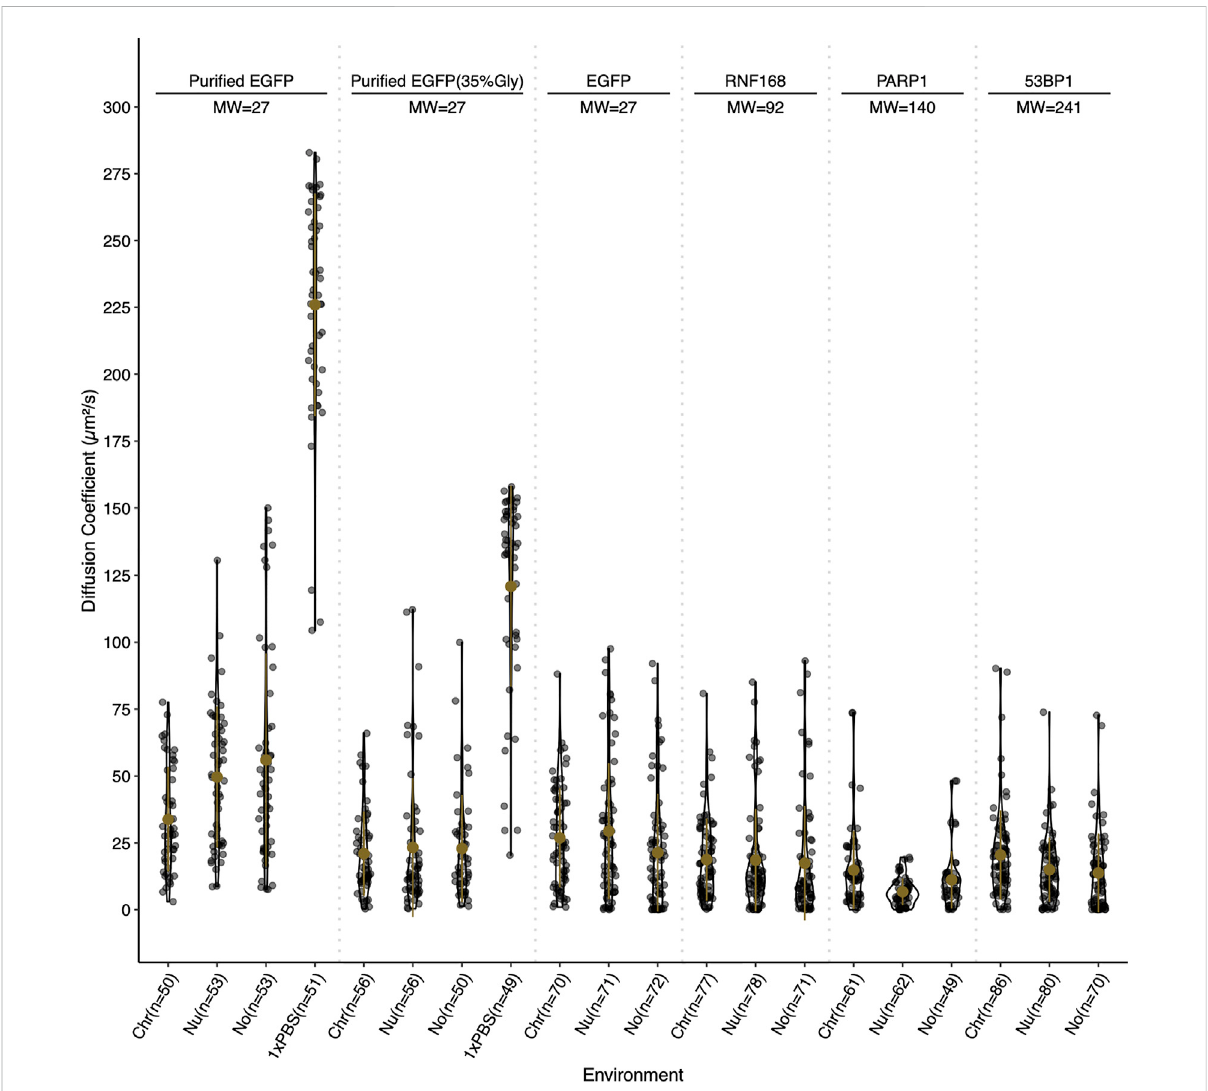
FIGURE 4 Relative diffusion of EGFP and selected DNA damage response proteins. Diffusion coef fi cients for EGFP, RNF168-EGFP, PARP1-EGFP, and 53BP1-EGFP in live cells, and puri fi ed EGFP in 0 and 35% glycerol in fi xed cells. Diffusion coef fi cients are reported in µm 2 /s and were determined by fl uorescent correlation spectroscopy. Diffusion coef fi cients are reported for the chromocenter (Chr), the nucleoplasm (Nu), the nucleolus (No), and forpuri fi edEGFPin1×PBS(1×PBS).Livecellmeasurementsweregatheredat37 ° Cand fi xedcellmeasurementswerecollectedat18 ° C.Bothlive and fi xed cells were stained with Hoechst 33342 to visualize